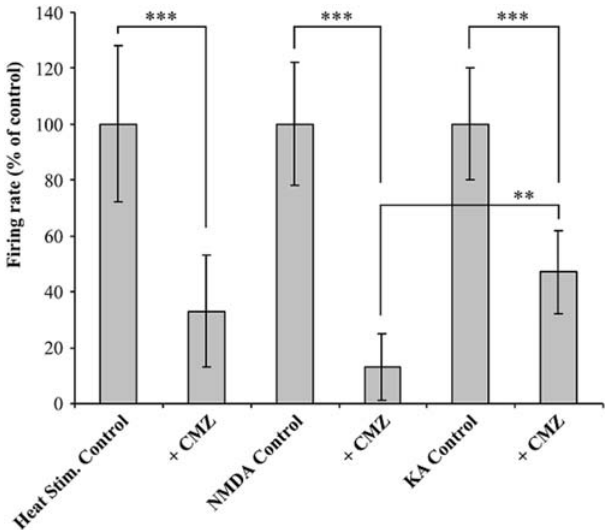
Figure 9. Summary of the effects of calmidazolium (CMZ) on the responses to heat or to iontophoresed excitatory amino acids of spinal dorsal horn neurons of nociceptive specific (NS) or wide dynamic range (WDR) types. Note the decrease of the responses in the presence of calmidazolium. Asterisks denote significant differences by ANOVA (**p , 0.05, ***p , 0.01) as compared to their respective controls or the significant difference between the decrease of NMDA- and kainic acid - evoked responses in the presence of calmidazolium. See details in the text. Clotrimazole 6; M7, N-Benzyl Imidazole; SB 290157, N2-[(2,2- Diphenylethoxy)acetyl]-L-arginine; W-7, N- 6 – aminohexyl – 5 – chloro - 1 naphtalenesulfonamide; W-13, N - (4 - Aminobutyl) – 5 - chloro -2- naphthalenesulfonamide.